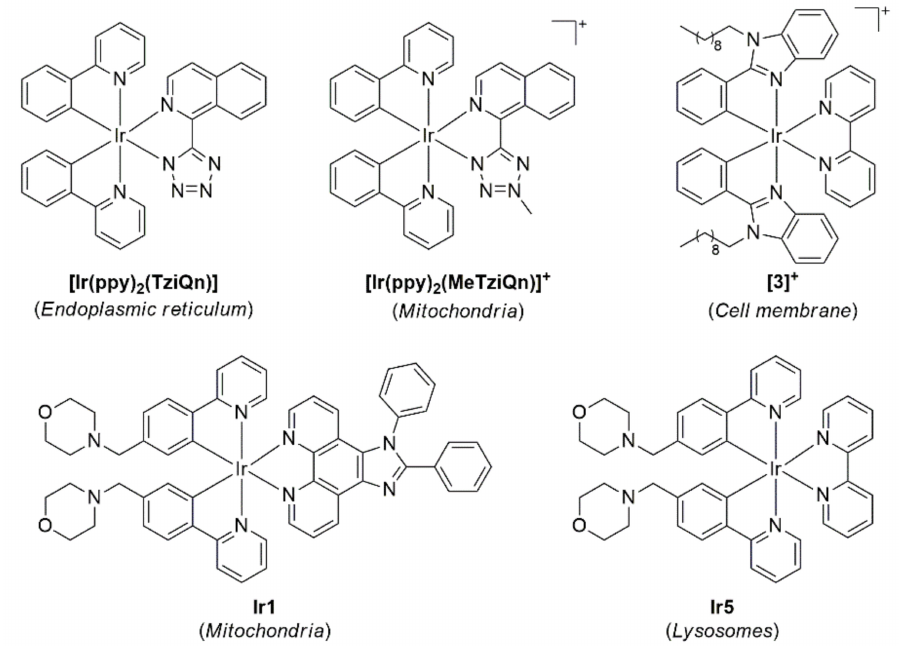
Figure 8. Structures of Ir(III) complexes with organelle localisation highlighted in parenthesis.